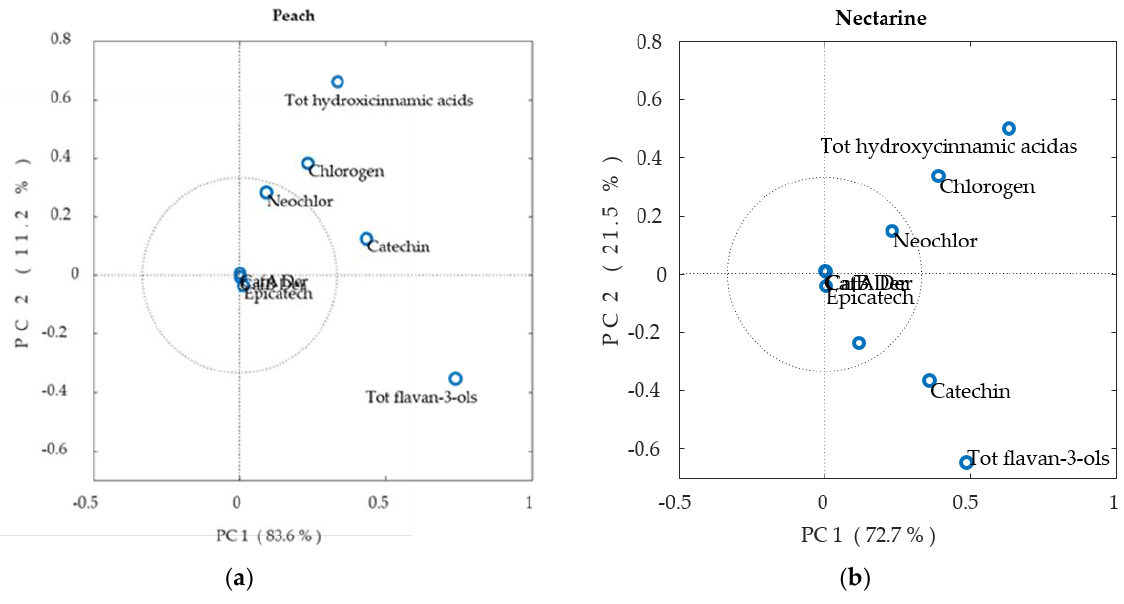
Figure 5. Principal component analysis (PCA) diagrams of HPLC data of peach ( a ) and nectarine ( b ) samples.